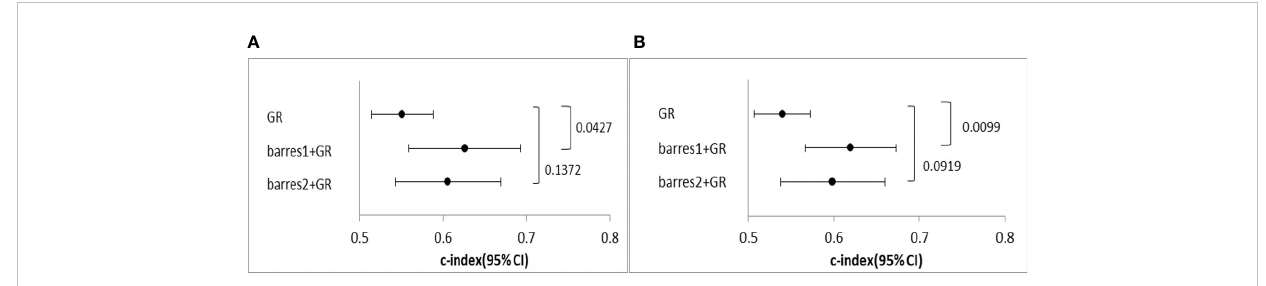
FIGURE 4 Comparison of the predictive power of the GR and the GR and b -arrestin combination. (A) , C-index of univariate Cox regression analysis for OS. (B) , C-index of univariate Cox regression analysis for PFS. The GR and b -arrestin 1 expression combination showed a better predictive power than GR expression alone. However, the GR and b -arrestin 2 expression combination showed similar predictive power as GR expression alone.